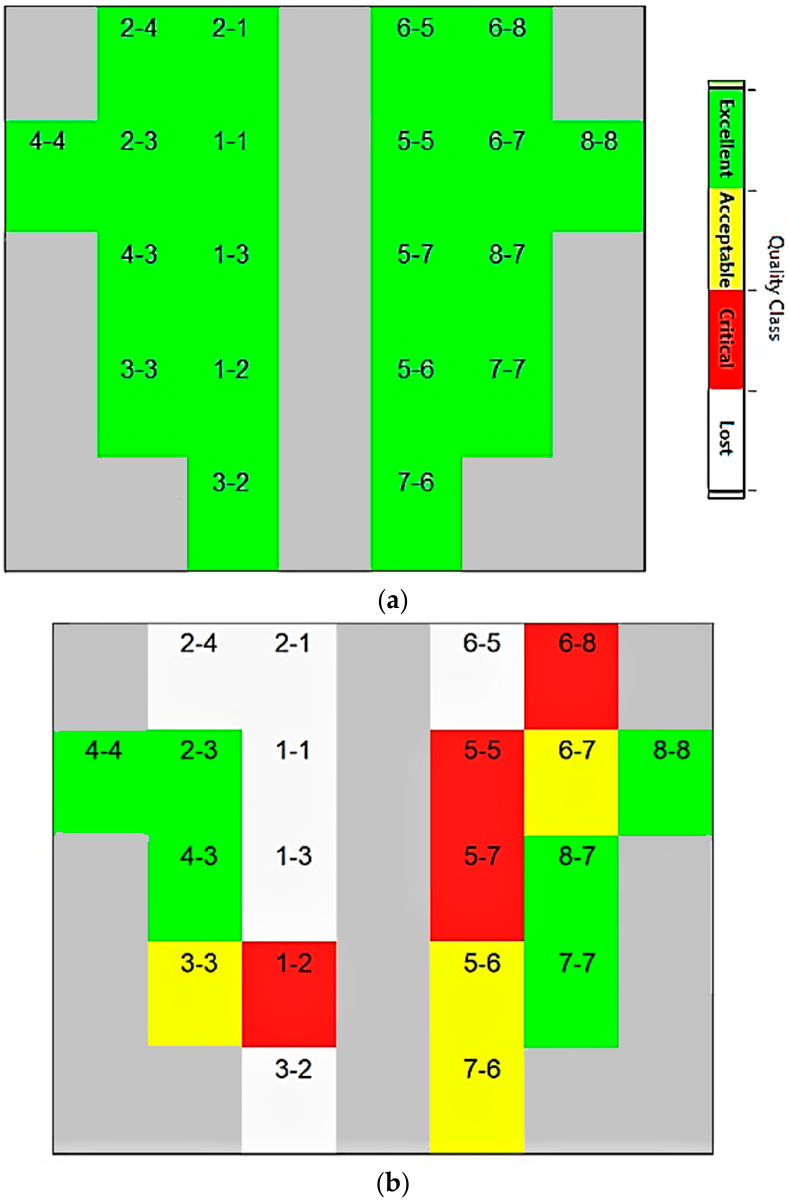
Figure 6. Optode status window. ( a ) Flawless optode connection with head scalp; ( b ) faulty optode connection. The signal quality class can be read from a color bar shown along with the optode status window.